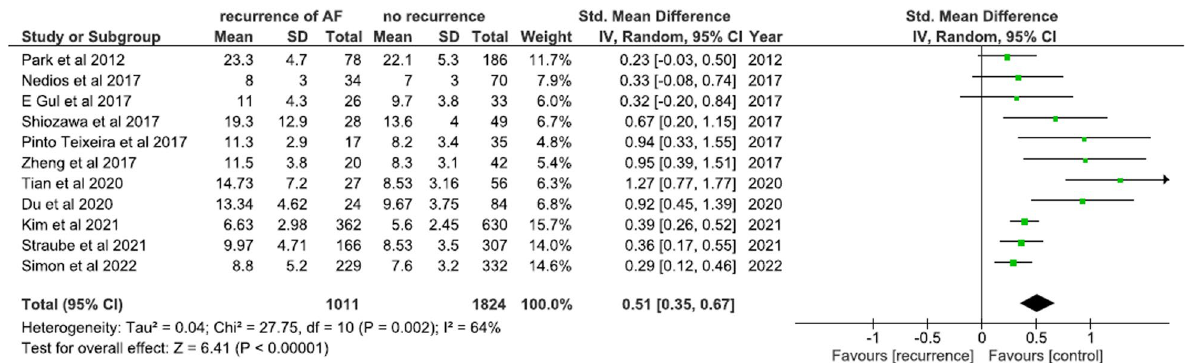
Fig. 3 Mean difference in LAA volume between arrhythmia recurrence and arrhythmia free groups